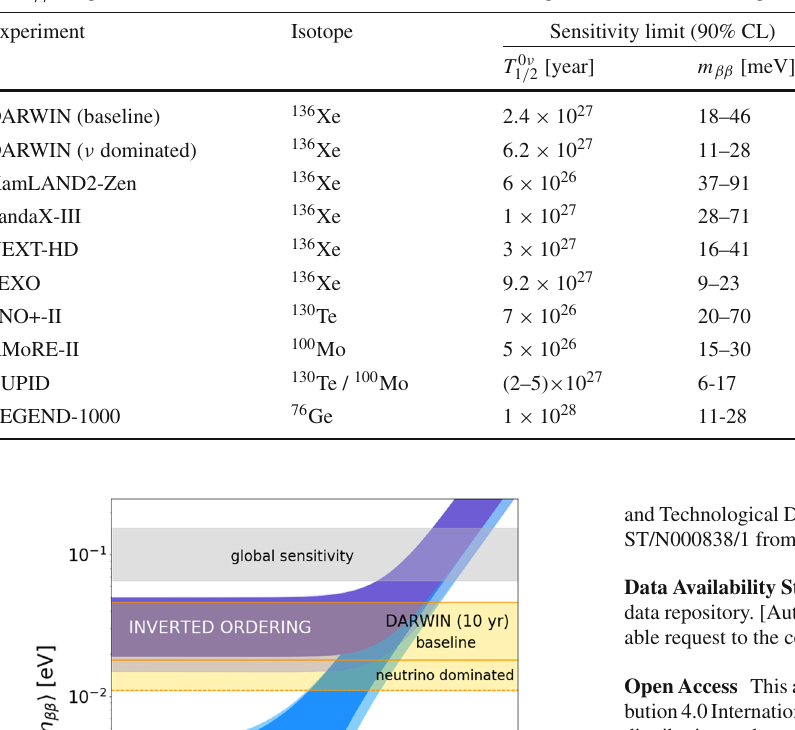
Table 4 Comparison of T 0 ν and m ββ sensitivity limits (90% CL) between DARWIN and future 0 νββ experiments. For experiments using 136 Xe 1 / 2 the m ββ ranges are calculated with the nuclear matrix element ranges from [36], those using other isotopes are taken from [37]